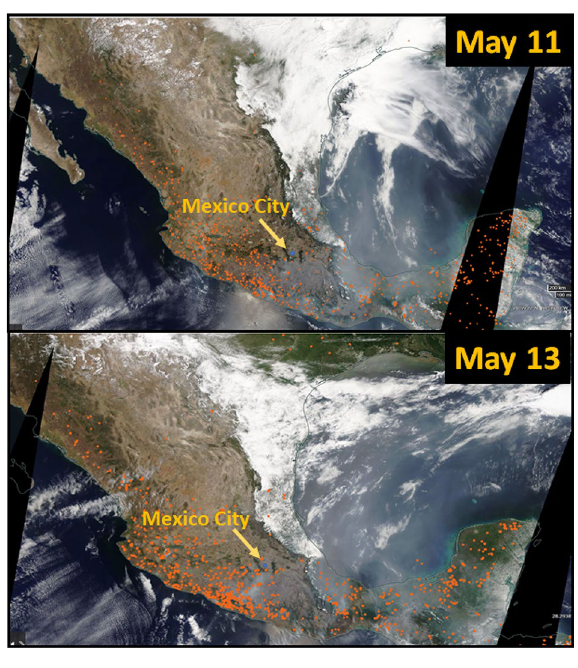
Figure 2. Spatial distribution of active fires (red dots) in Mexico detected by the Visible Infrared Imaging Radiometer Suite (VIIRS) on May 11 and 13, 2019 (Courtesy NASA, https:// world view. earth data. nasa. gov).